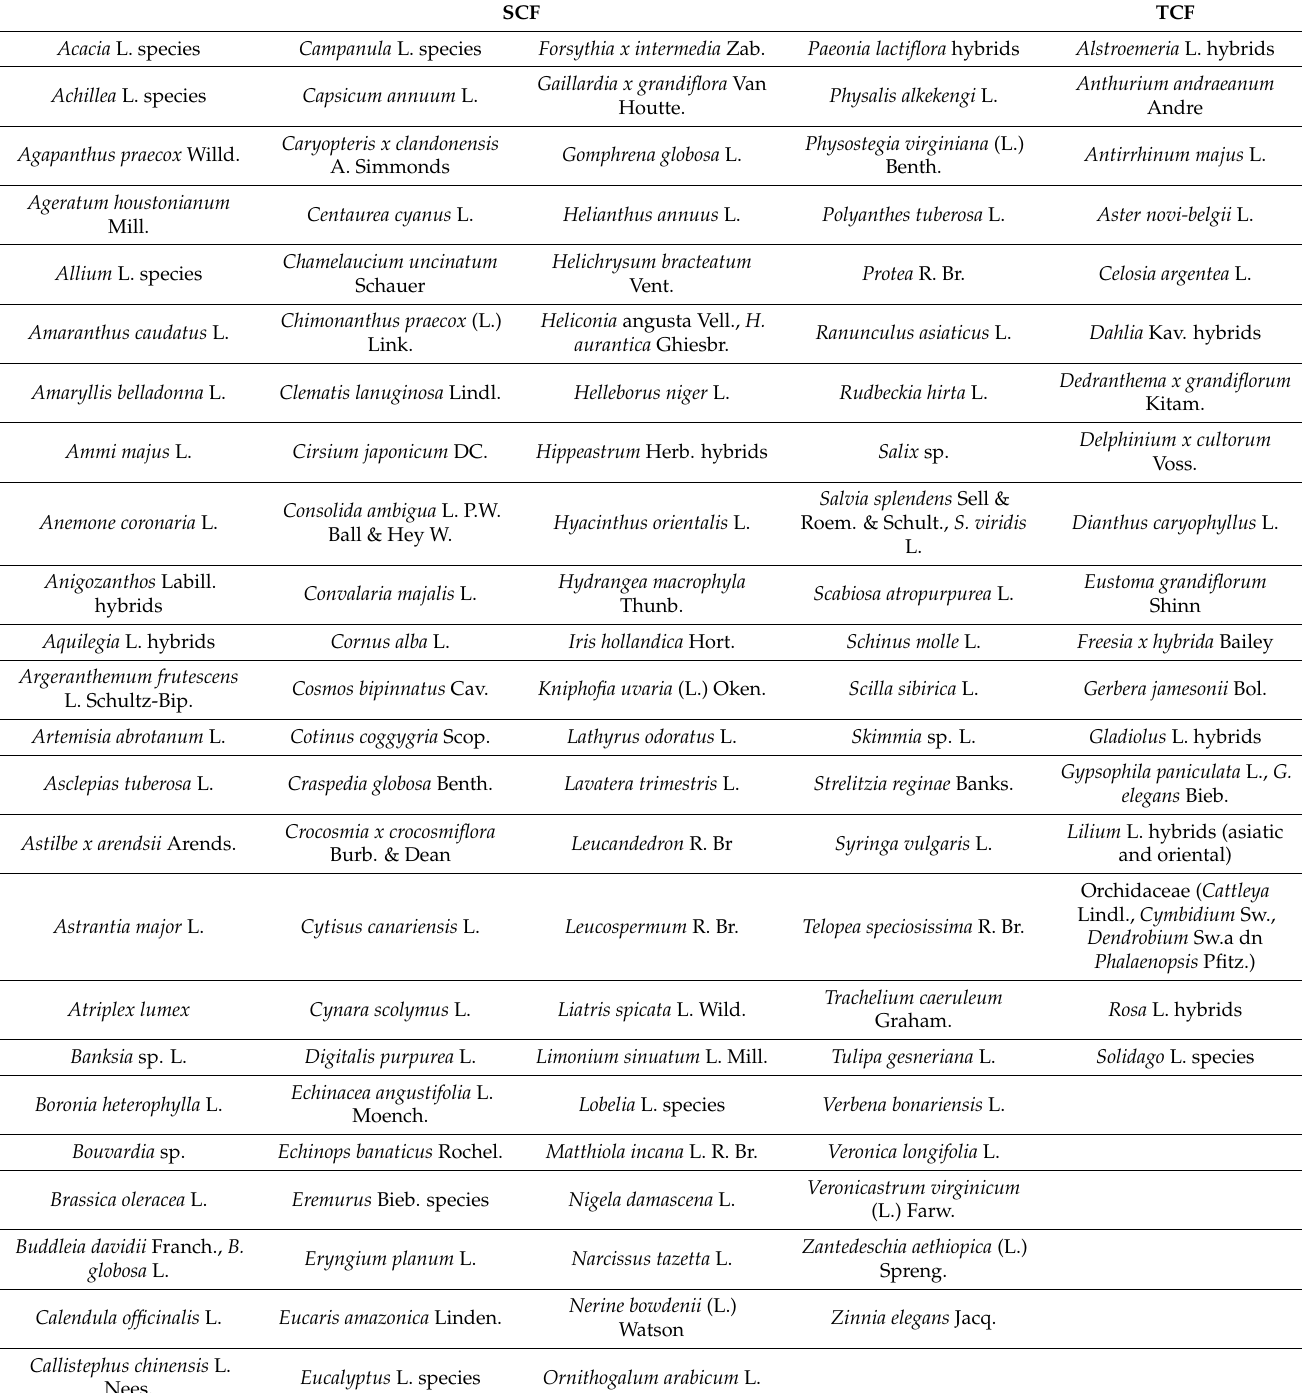
Table 1. List of selected annual, perennial, and bulb specialty cut flowers (SCF) grown mainly outdoors at certain times of the year and traditional cut flowers (TCF) cultivated all-year round mainly inside greenhouses at different parts of the world